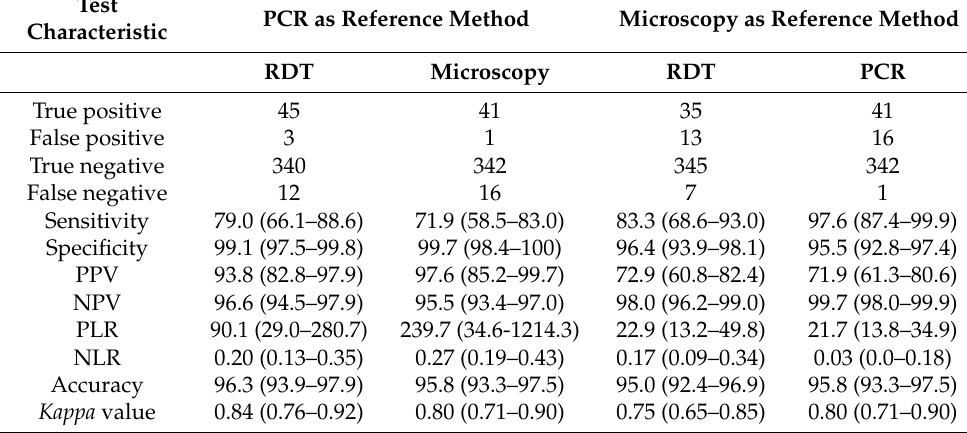
Table 2. Overall performance of light microscopy, RDT, and PCR techniques in the diagnosis of malaria (n =